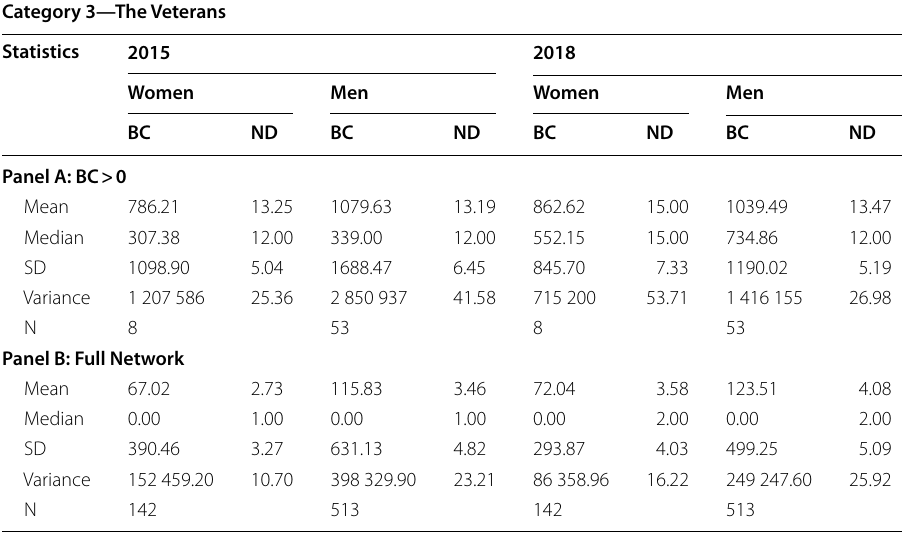
Table 10 Category 3 – The Veterans: directors present in both the 2015 and 2018 Networks Category 3—The